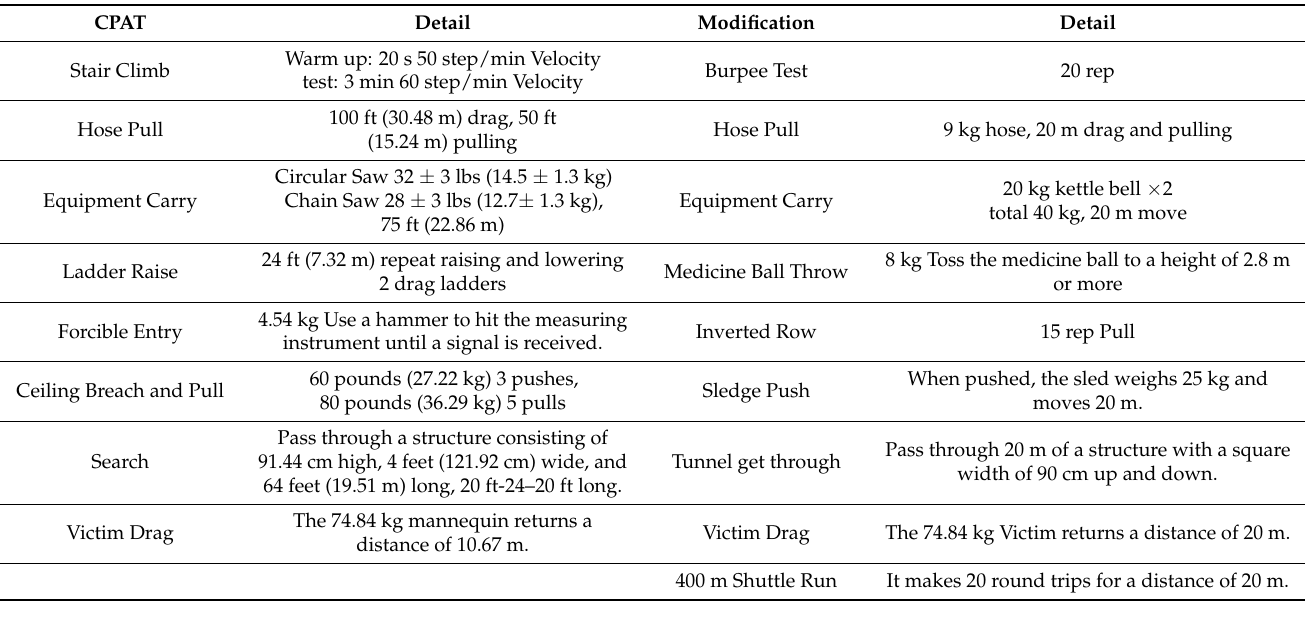
Table 2. Comparison of CPAT and modified physical fitness test [10].